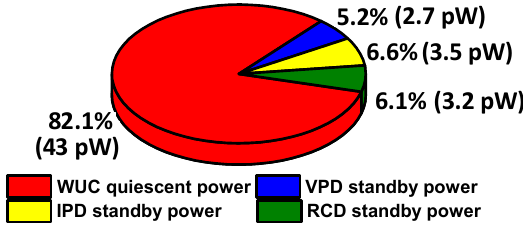
Figure 7. Harvesting interface standby mode power consumption pie chart.